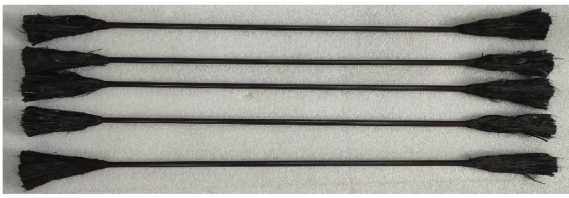
Figure 8: CFRP rods with exposed fibers at both